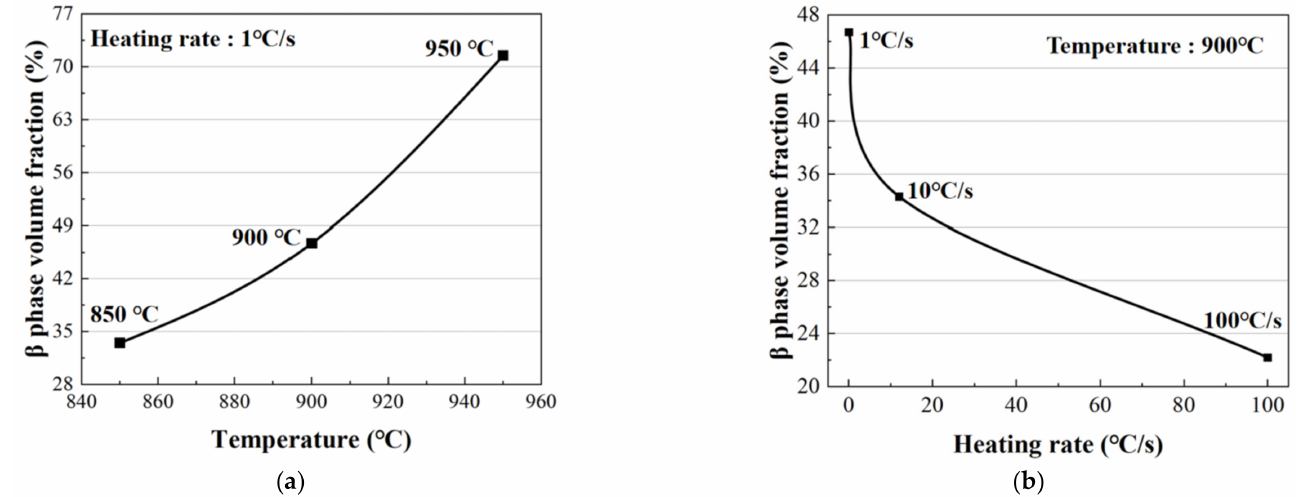
Figure 9. Volume fractions of the β phase at different ( a ) forming temperatures and ( b ) heating